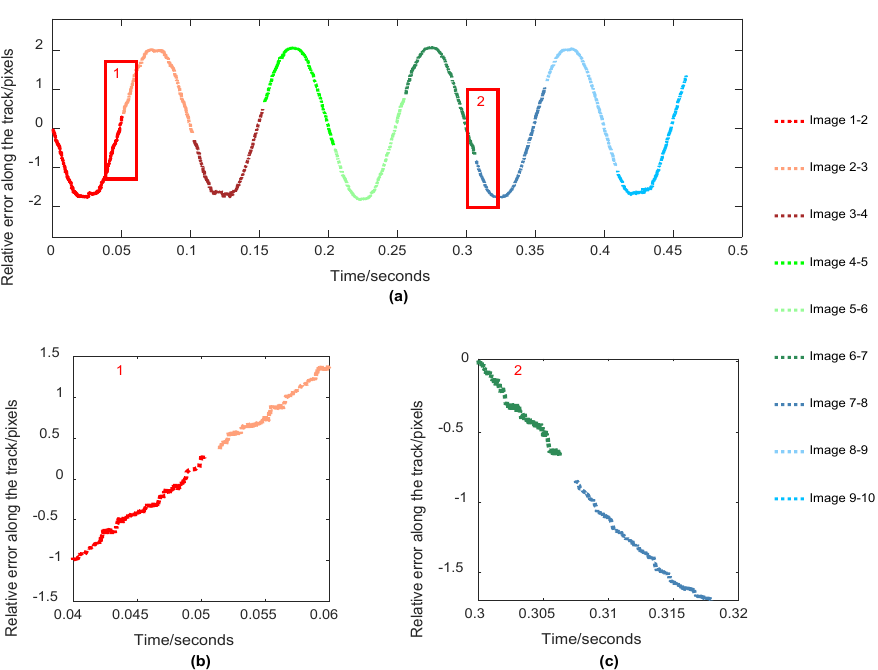
Figure 9. The 10-Hz jitter detection curves by sequential disparity maps. ( a ): The whole detected results; ( b ): The local amplification of rectangular area 1 in ( a ); ( c ): The local amplification of rectangular area 2 in ( a ).